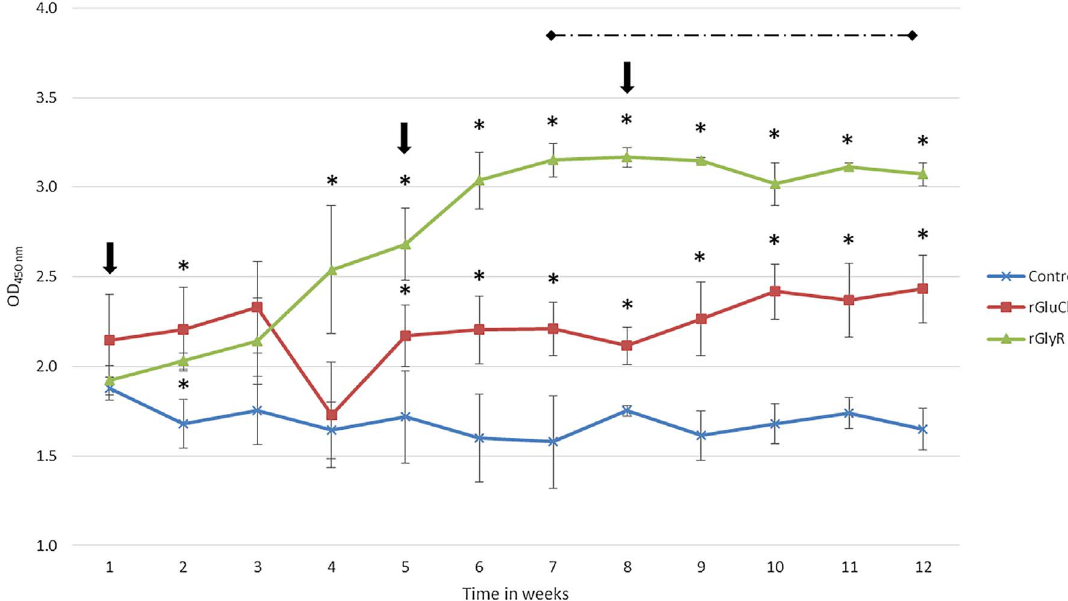
Figure 4. Antibody response in vaccinated cattle. Bovine serum antibody levels to recombinant antigens were determined by ELISA in cattle vaccinated with rGluCl, rGlyR and adjuvant/saline control. Antibody levels in immunized cattle were expressed as OD 450 nm values and compared between vaccinated and control cattle using an ANOVA test (* p < 0.05). The time of vaccination shots (arrows) and tick infestations (dashed line) are